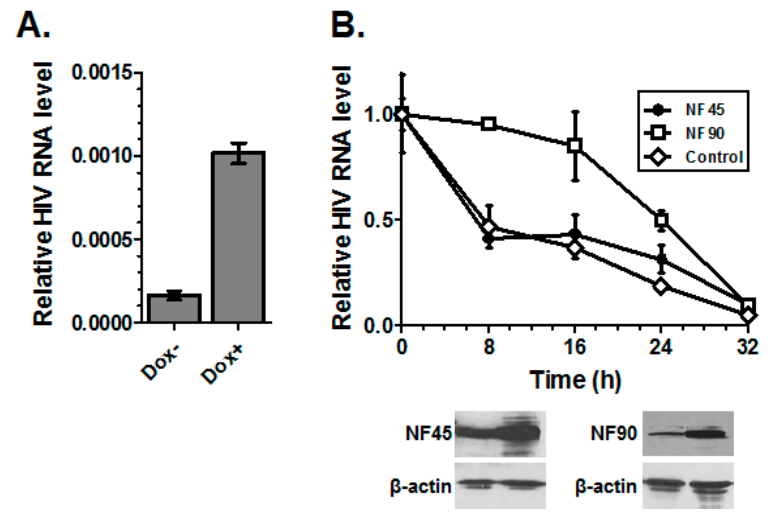
Figure 8. NF90 stabilizes the HIV RNA. ( A ) Inducible expression of HIV RNA. Transcription of HIV RNA in doxycycline inducible cell line ( B ) RNA stability assay. HeLa-HIV RNA cells were transfected with empty vector, pCMV-NF45 or pEF-NF90. After 24 h doxycycline was added to each well to induce the expression of HIV RNA. At 12 h post induction the cells were washed three times with warm cDMEM and returned to normal media to halt transcription. RNA was harvested at the indicated times and quantified by real-time RT-PCR. Results were normalized to the level of 18S RNA. Error bars represent standard deviation of triplicate PCR reactions.